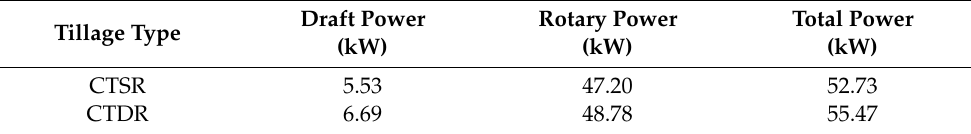
Table 4. The power characteristic of combined tillage implement by simulation.